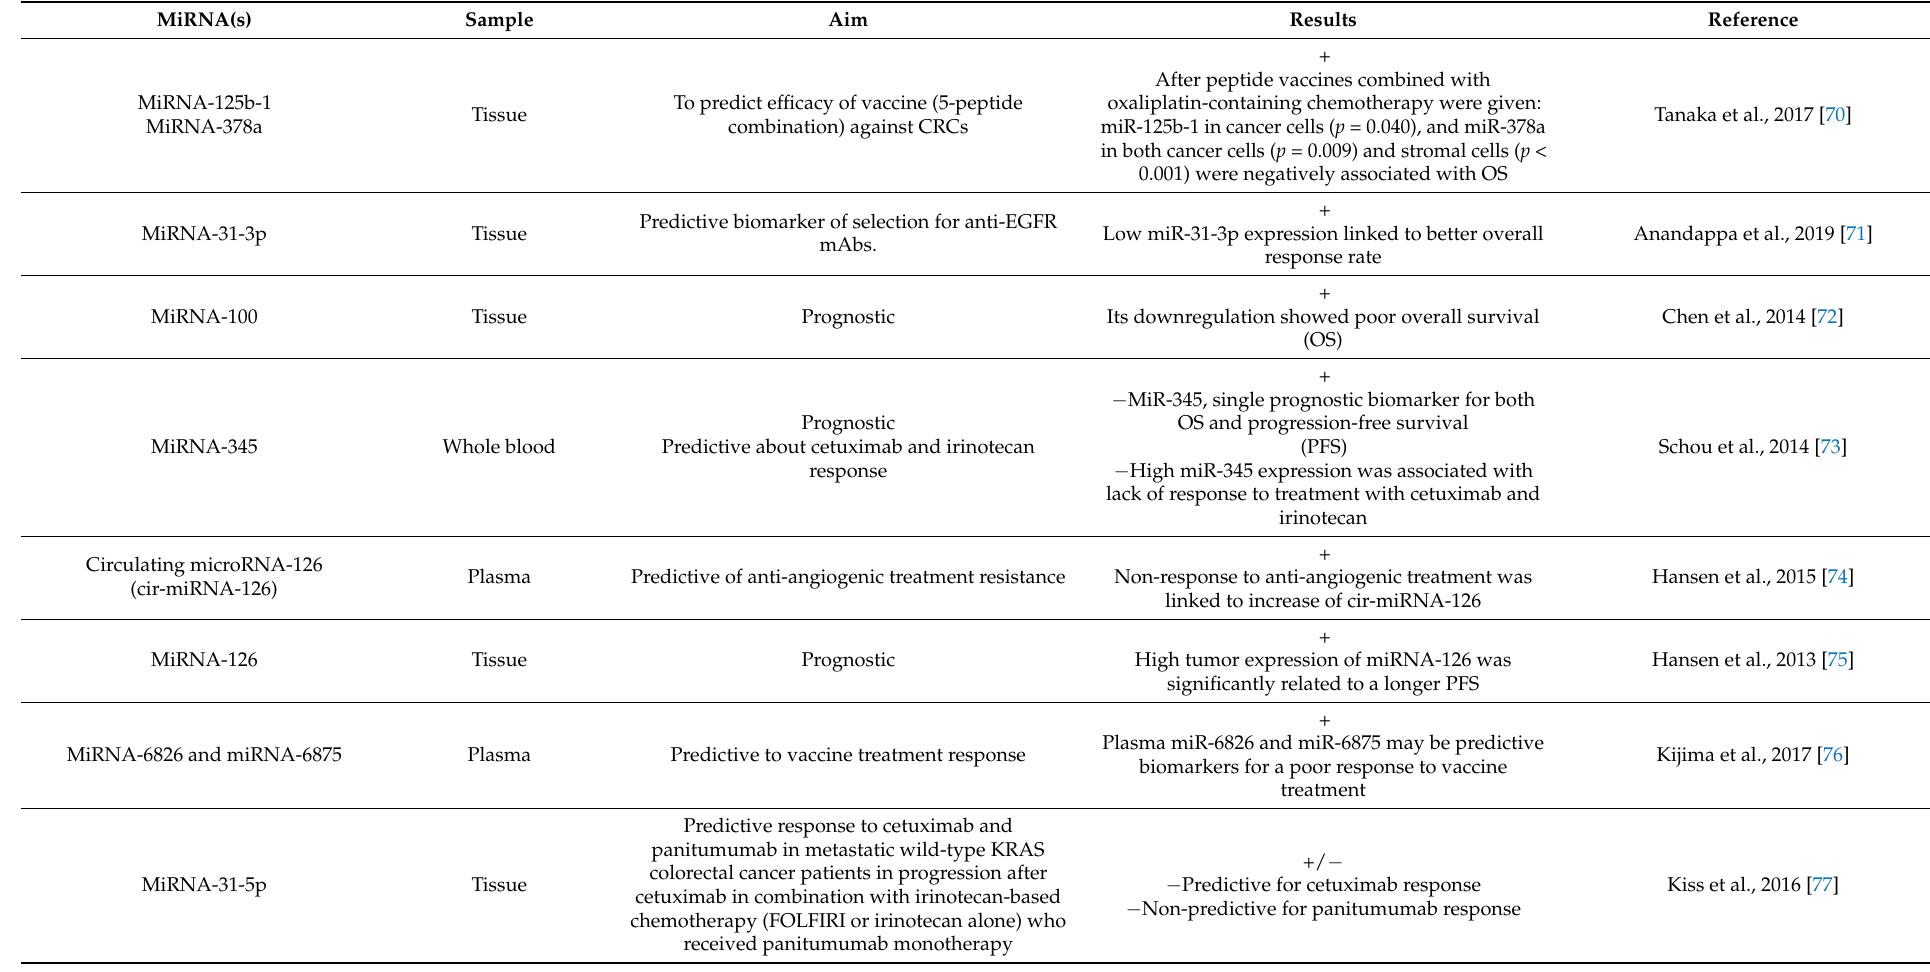
Table 3. MiRNAs as prognostic